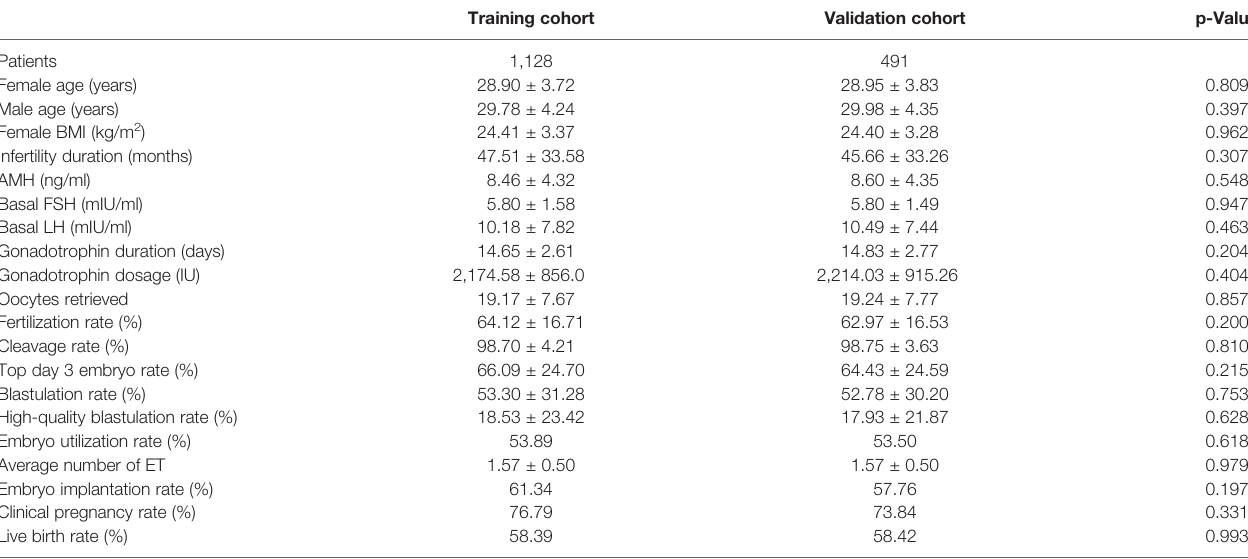
TABLE 2 | Characteristics of PCOS group in the training and validation